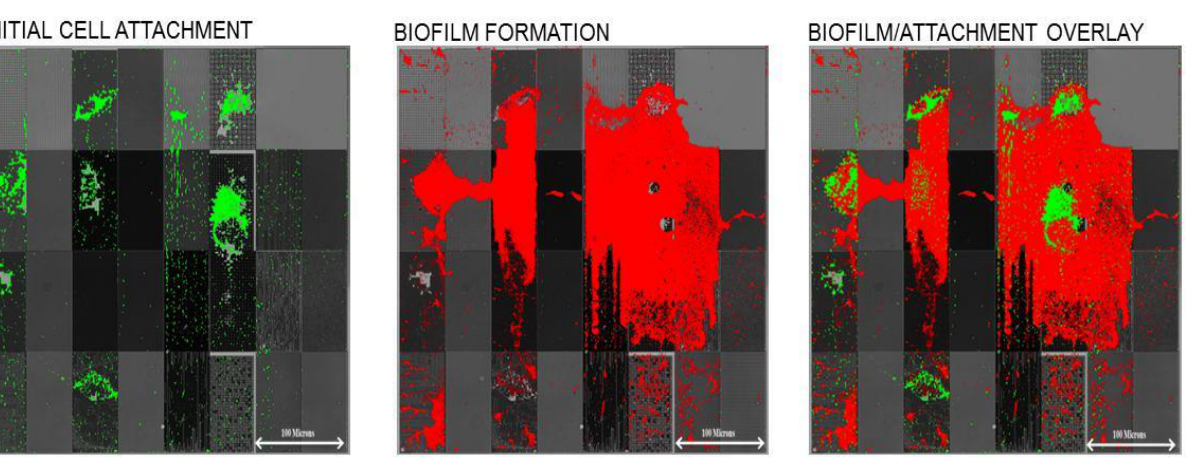
Figure 5. Initial attachment and subsequent biofilm formation by P . aeruginosa on micron and sub-micron engineered surface topography (original data from Graham and Cady, figure adapted from our original work in Ling et al . [53]) with permission of World Scientific Publishing Company © 2012. The arrangement of topographical patterns in each panel is the same as shown in Figure 4. Scale bar is equal to 100